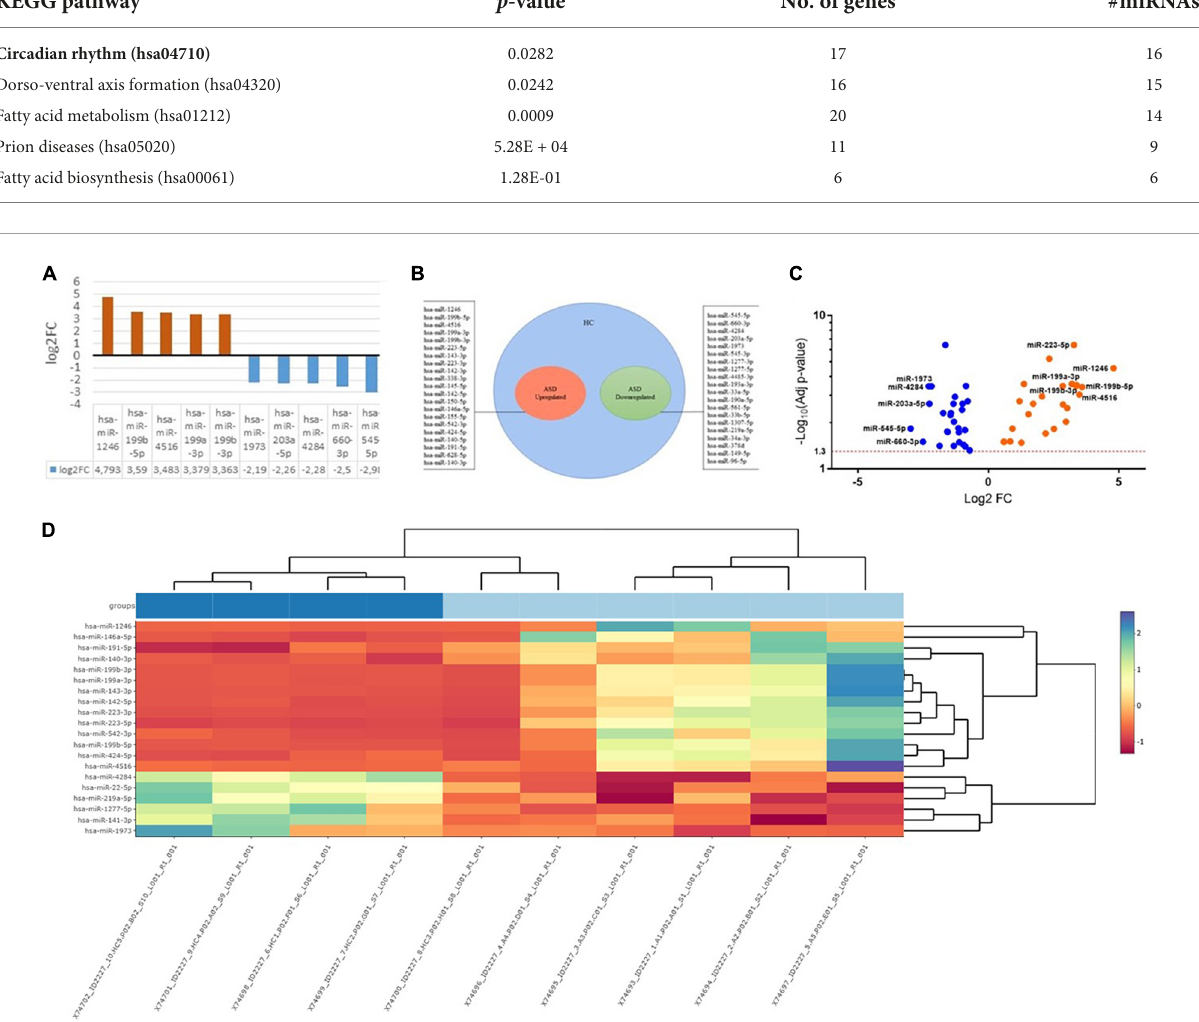
FIGURE1 (A) The top miRNAs dysregulated in ASD patients compared to healthy control. (B) Venn Diagram. (C) Volcano plot of the identified miRNAs. (D) Heat map diagram showing cluster analysis of differently expressed miRNAs. The miRNAs selected are differentially expressed between ASD and HC (Healthy Control) groups ( p < 0.05). The color scale reflects the signal strength and goes from green (low intensity) to black (medium intensity) to red (high